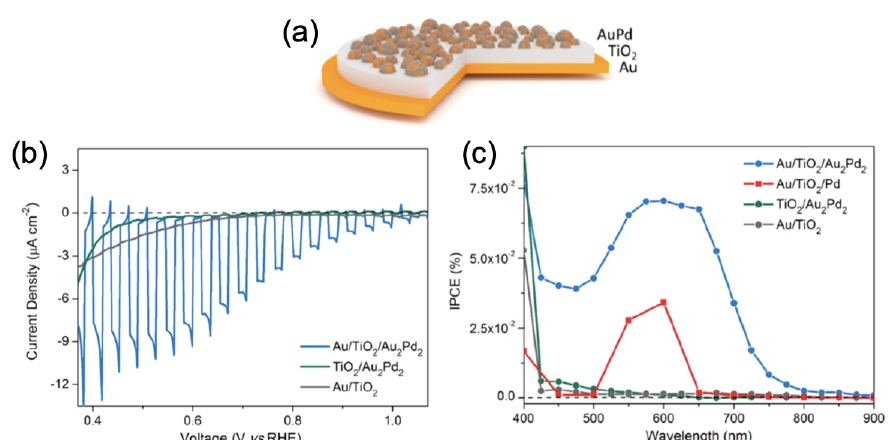
Figure 6. ( a ) Principle scheme of the plasmonic metasurface. ( b ) Linear sweep voltammogram scans with chopped visible light. ( c ) Incident photon conversion efficiency (IPCE) versus wave- length. All the figures are reprinted (adapted) with permission from [86], Copyright 2021 American Chemical